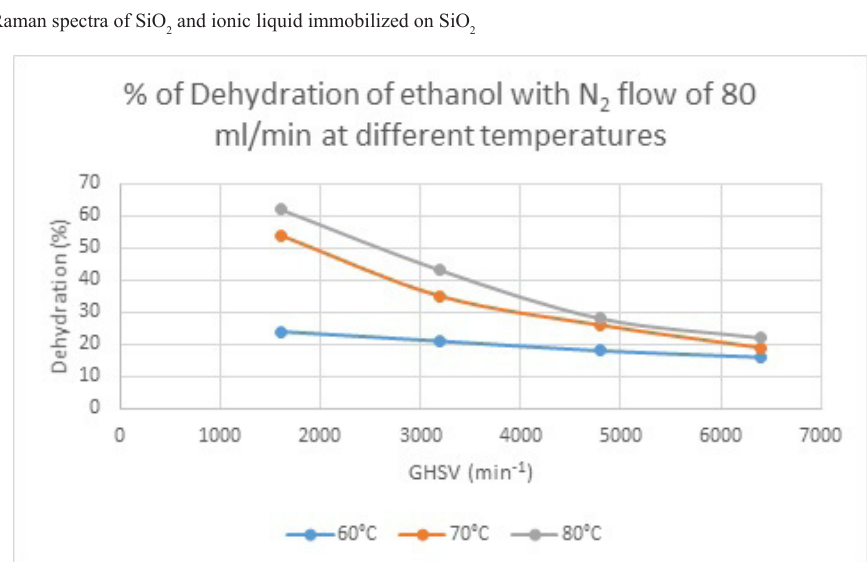
Figure 10. Raman spectra of SiO